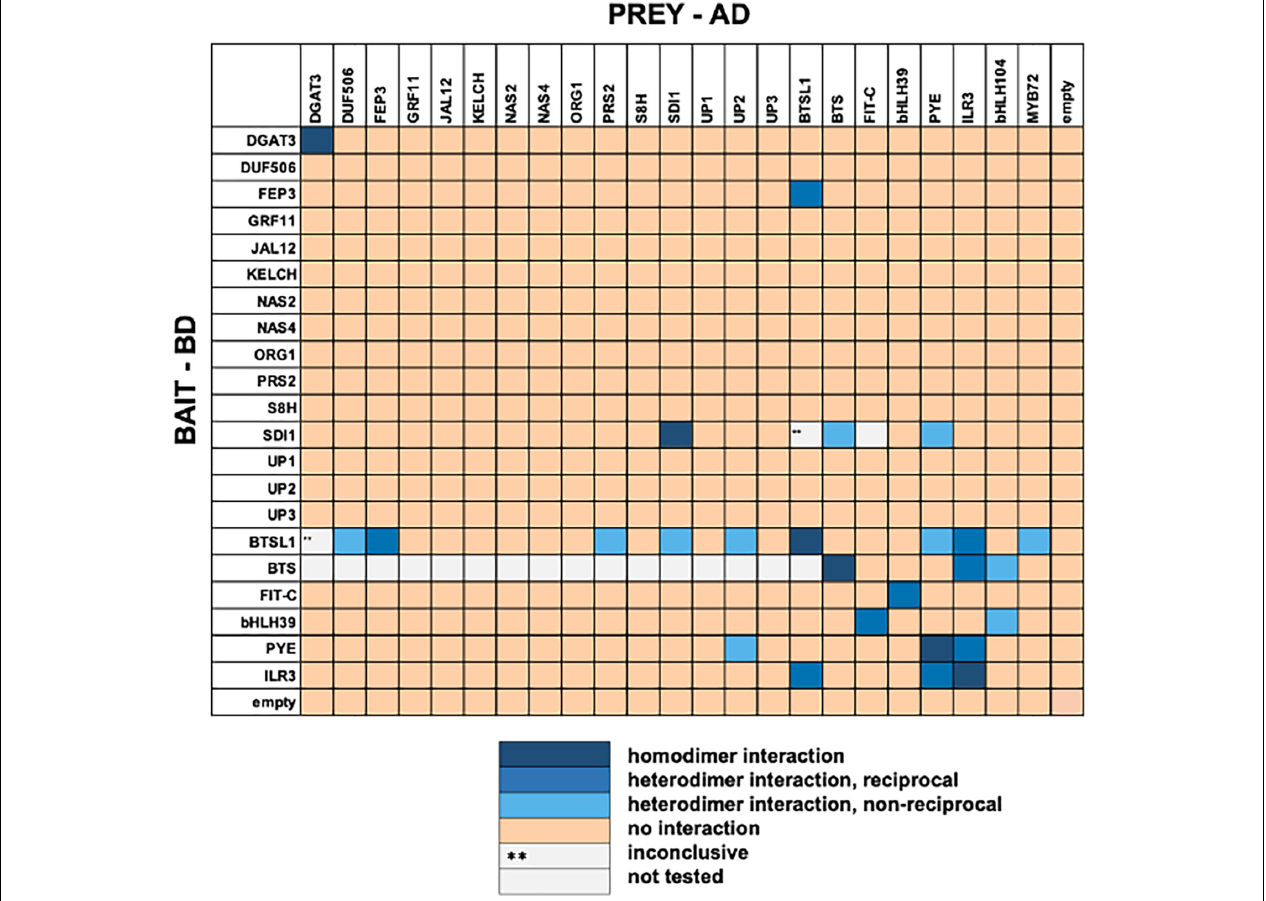
Frontiers in Plant Science |